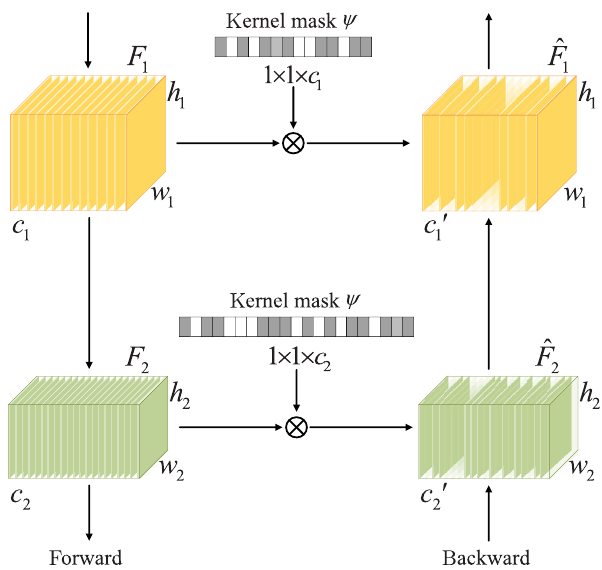
Fig. 2 Weight asynchronous update training strategy. c , w , and h are channel, width, and height,